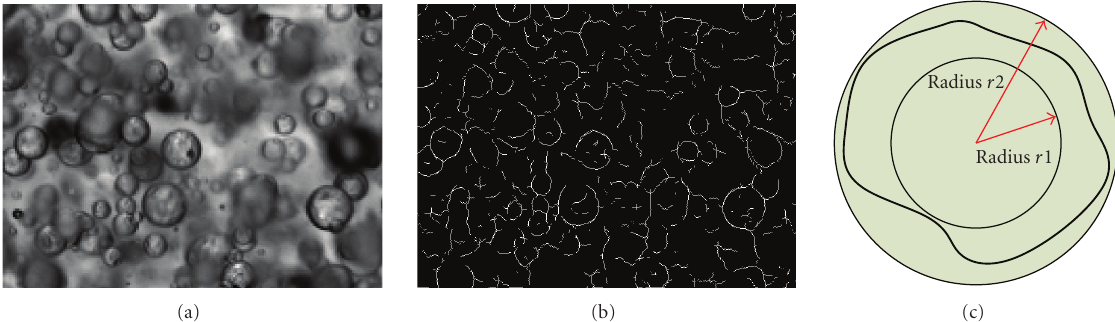
Figure 5: (a) Original image; (b) the resulting contour image; (c) representation of the drop contour as an irregular object.